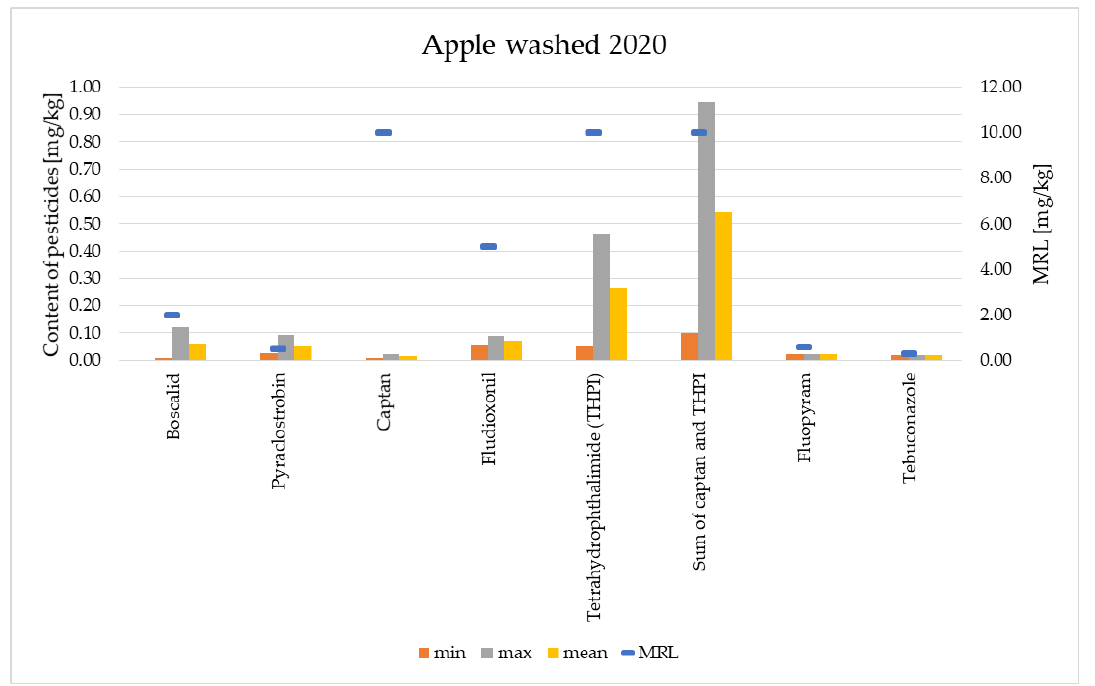
Figure 16. Content of pesticides in samples of apples washed with water (2020).